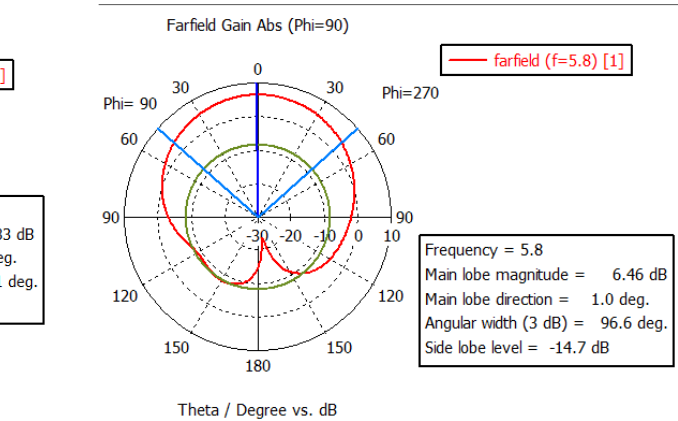
Figure 4. Far field region for FR4.